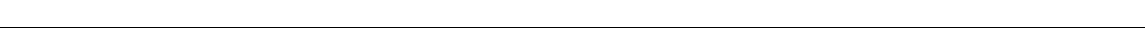
Fig. 3 Role of Csul methyltransferase and Tud for Aub functions in mRNA decay and localization. a , e Immunostaining with anti-Osk and anti-Aub, and nos mRNA in situ hybrydization of 0 – 2 h- csul ( a ) and -tud ( e ) mutant embryos. Quanti fi cations of posterior localization in embryos shown in a , e are indicated (right panels). Scale bars: 30 μ m. b , f PAT assays of nos mRNA in embryos at 1 h-intervals up to 4 h of development in wild type, csul ( b ) and tud ( f ) mutants. sop was used as a control mRNA. c , g nos mRNA quanti fi cation using RT-qPCR in 2 – 3 h wild-type, csul ( c ) and tud ( g ) mutant embryos. Normalization was with RpL32 mRNA. For each genotype, mRNA levels at 2 – 3 h were normalized to the levels at 0 – 1 h. Means are from three biological replicates. The error bars represent SD. * p < 0.05 using the two-tailed Student ’ s t test. d , h nos mRNA in situ hybrydization of 2 – 4 h wild-type, csul ( d ) and tud ( h ) mutant embryos. Box plots showing the quanti fi cation of nos mRNA stabilization in the somatic part of the embryo. The central horizontal bar represents the median. ns: non-signi fi cant, *** p < 0.001, using the two-tailed Student ’ s t